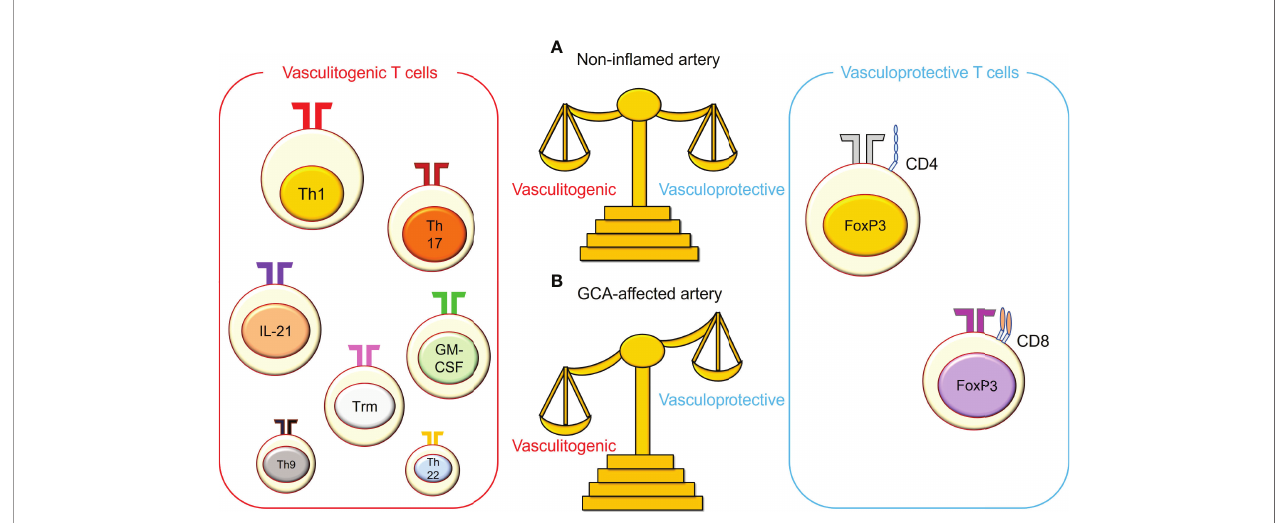
FIGURE 2 | The imbalance between vasculitogenic T cells and vasculoprotective T cells in giant cell arteritis. (A) In non-in fl amed arteries, vasculitogenic T cells and vasculoprotective T cells are well balanced in the blood, and both cell types are rare in the vasculature. (B) In giant cell arteritis (GCA), this balance is perturbed, and vasculitogenic T cells accumulate, while the number of vasculoprotective T cells decreases in the tissue and the blood. Vasculitogenic T cells include T helper 1 (Th1) cells, Th17 cells, IL-21-producing T cells, granulocyte macrophage-colony stimulating factor (GM-CSF)-producing T cells, tissue-resident memory T (Trm) cells, Th9 cells, and Th22 cells. On the other hand, vasculoprotective T cells include CD4 + regulatory T cells and CD8 + regulatory T